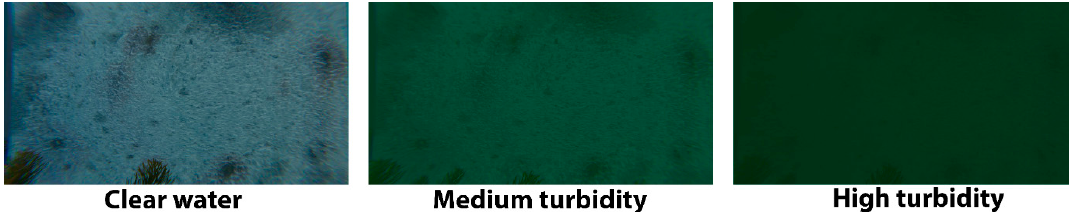
Figure 13. Image of a corroded surface on a wharf captured under clear, medium turbidity, and high turbidity conditions.